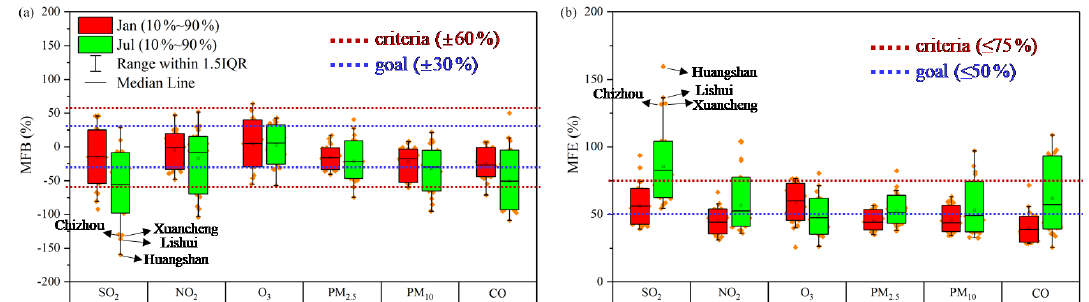
Figure 9. MFB (a) and MFE (b) between the simulation and observation data for daily average concentrations of various pollutants of the cities in the YRD region in January and July